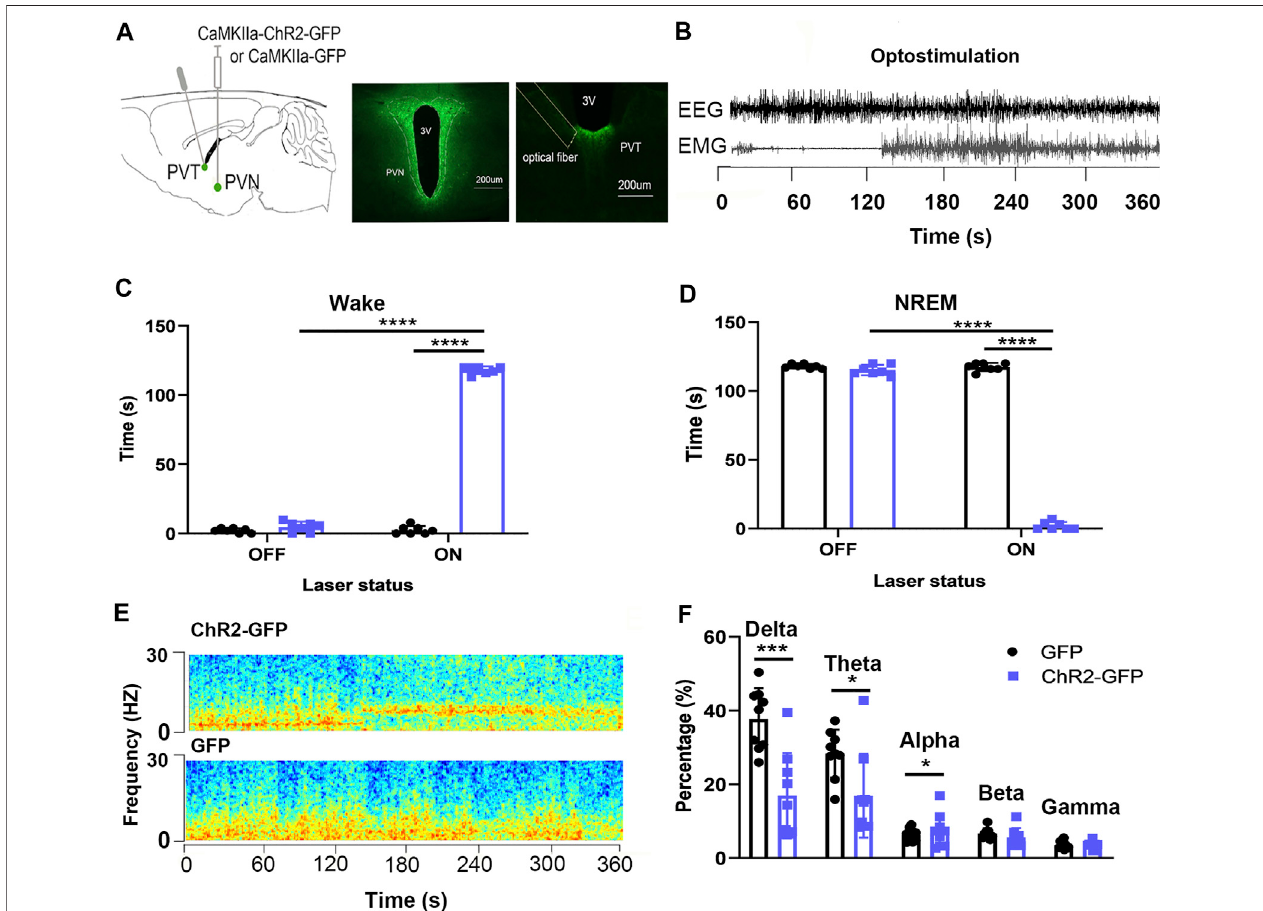
FIGURE6| Optogenetic activationofthePVN-PVTneuralcircuitpromotes wakefulness. (A) Theimage showed theexpression oftheChR2-GFPvirusinPVN and ChR2-expressingPVNglutamatergicterminalsandthelocationofoptical fi berinthePVT. (B) EEGandEMGtracesbefore,during,andafterthe120sopticalstimulation. (C) Optical stimulation of PVN glutamatergic terminals to the PVT increased the wake time. (D) Optical stimulation of PVN glutamatergic terminals to the PVT decreased the NREM time. (E) Representative EEG power spectrum around 10 Hz stimulation delivered during NREM sleep. Color scale indicates the power (mV2) of raw power spectral density. (F) The percentage of delta in EEG power decreased after optic stimulation ofPVN glutamatergic terminals tothe PVT (* p < .05, ** p < .01, *** p < .001, n = 9/group. Error bars denote SEM. Two-way repeated measures ANOVA was performed followed by Bonferroni ’ s post hoc comparisons).